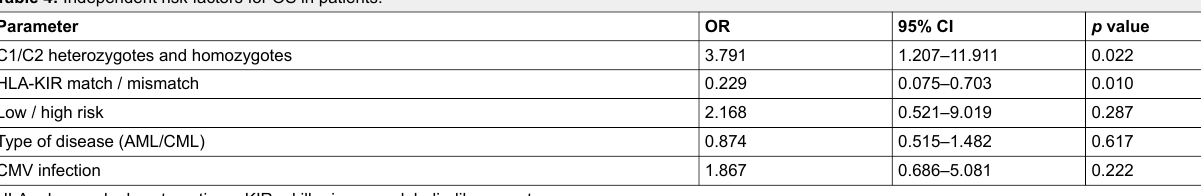
Table 4: Independent risk factors for OS in